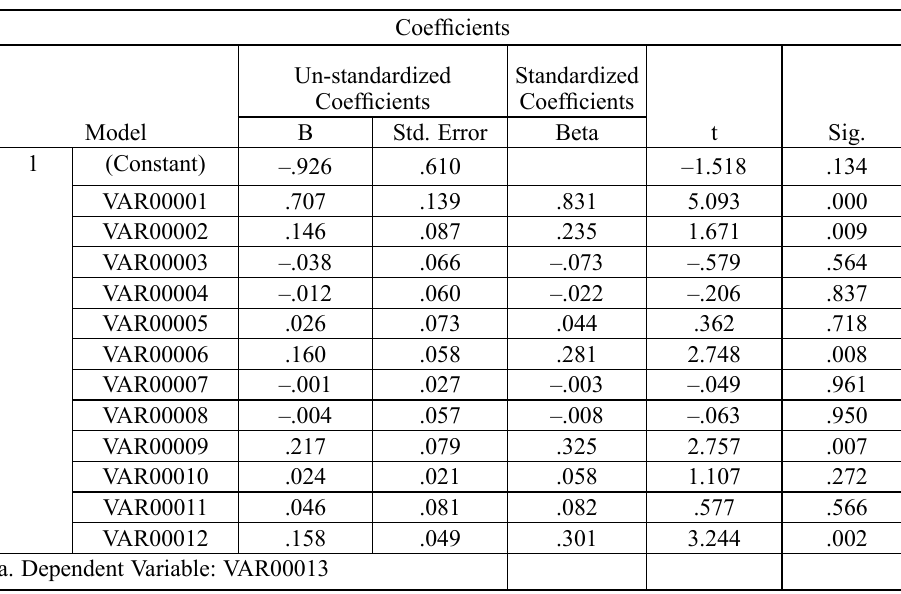
Table 3. Relationship between supplier retention with dependent